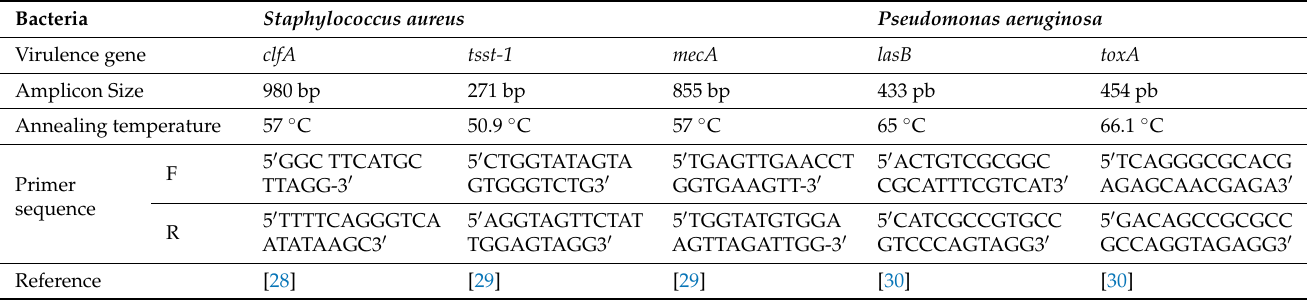
Table 2. Characteristics of Screened Virulence Genes; F: forward, R: reverse, bp: base